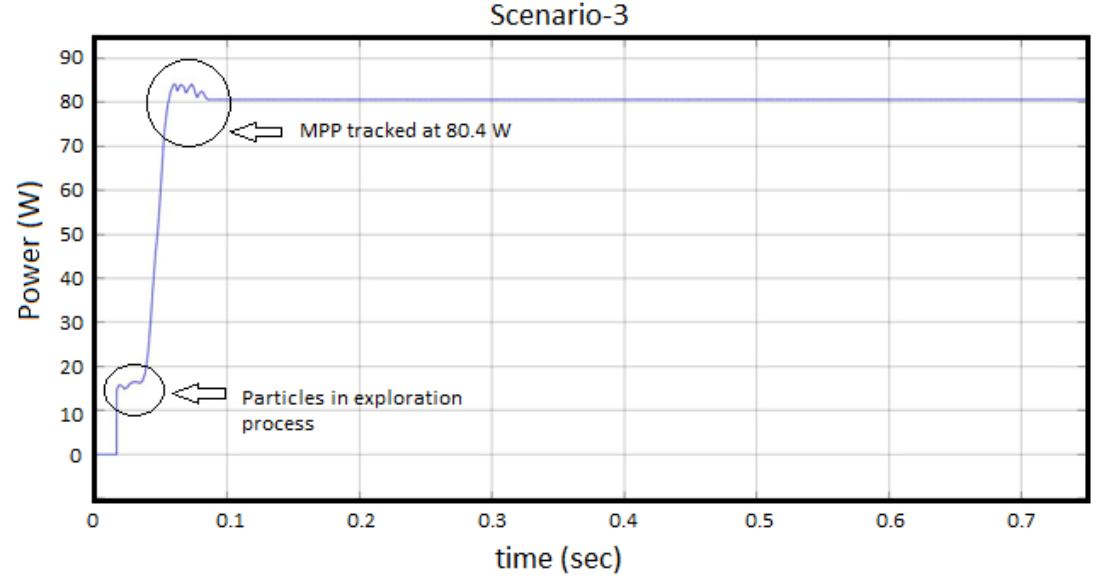
Figure 8. Performance of ICPSO under